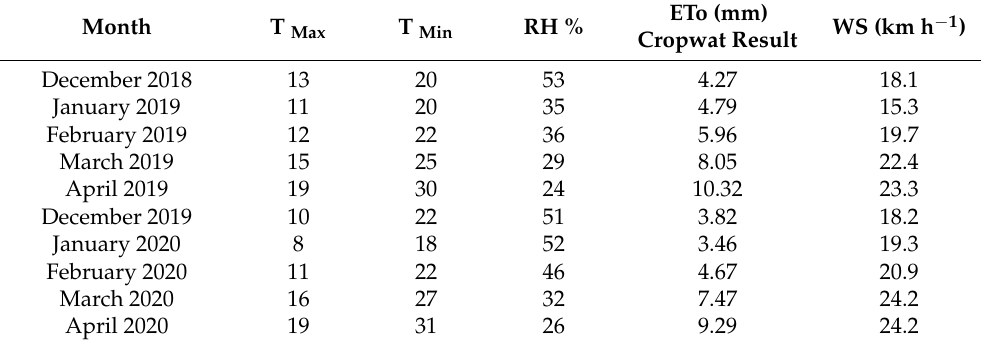
Table 2. Average maximum (T Max ) and minimum (T Min ) temperature, relative humidity (RH), wind speed (WS), and calculated evapotranspiration (ETo) during the 2018/2019 and 2019/2020 growing